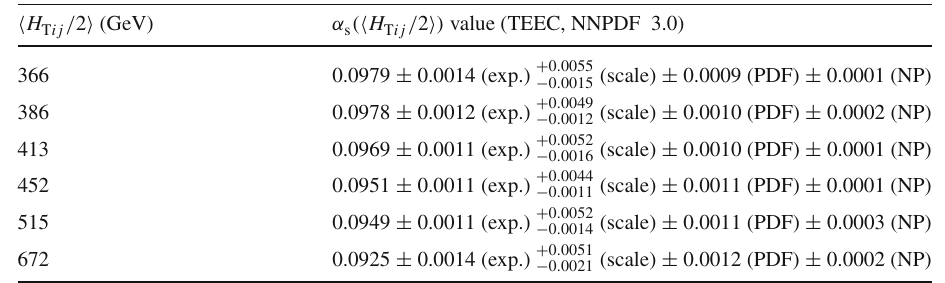
Table 11 Values of α s , obtained from ATEEC fits, evolved to the average value of the third-jet transverse momentum in each event, (cid:4) p T3 (cid:5) for each bin in H T2